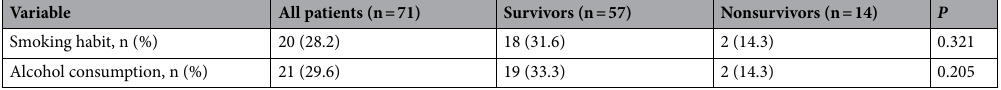
acute kidney injury (43.7%), severe consciousness disturbance (25.4%), shock (14.1%), and seizures (4.2%). Out of the 71 patients, 11 (15.5%) patients developed intermediate syndrome and three (4.2%) patients developed delayed neuropathy. Two patients with intermediate syndrome developed delayed neuropathy. One patient with intermediate syndrome died of shock in 16 days. The case was an 88 year-old female with a past history of old cerebral infarct who committed suicide by ingestion of diazinon pesticide. She was admitted to our hospital in 0.2 h, and the acute cholinergic syndrome was managed intensively. Intermediate syndrome developed in 50 h after exposure. Furthermore, she was complicated with aspiration pneumonia, acute kidney injury and acute respiratory failure during hospitalization. In addition, the nonsurvivors suffered higher incidence rates of hypo- tension (100.0% versus 24.6%, P < 0.001), shock (64.3% versus 1.8%, P < 0.001) and acute kidney injury (85.7% versus 33.3%, P = 0.001) than survivors did. Table 4 revealed that the nonsurvivors suffered lower blood cholinesterase levels (initial 0.53 ± 0.30 U/mL versus 3.20 ± 3.84 U/mL, P = 0.012; nadir 0.43 ± 0.30 U/mL versus 2.56 ± 3.18 U/mL, P = 0.025) than survivors